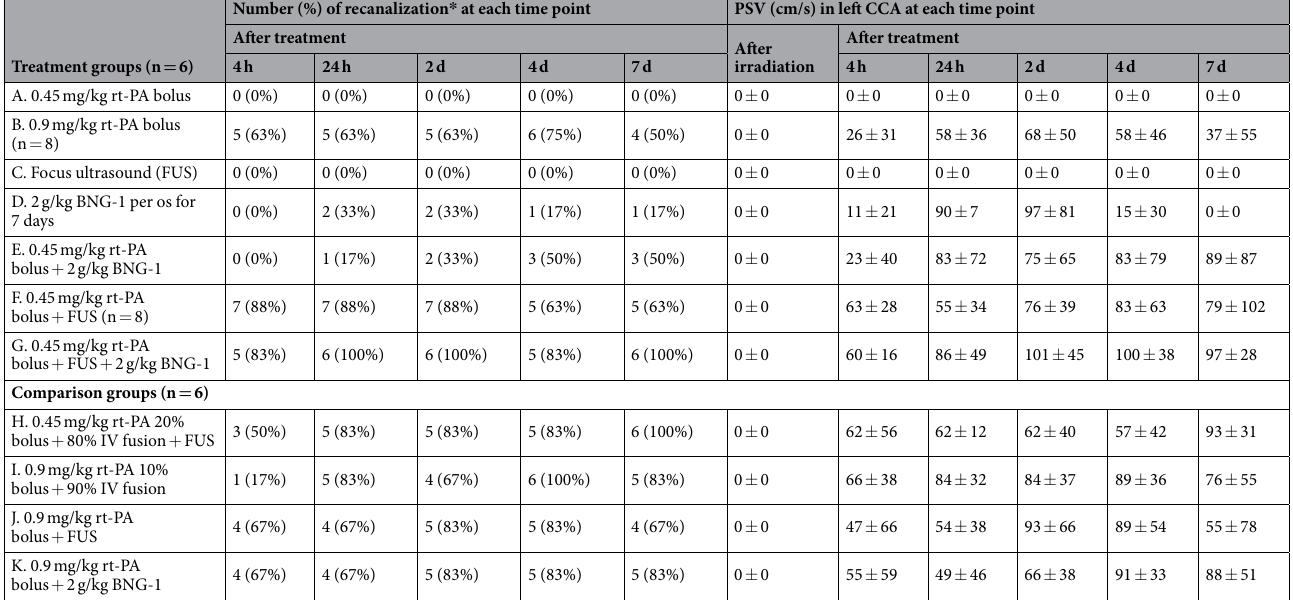
Table 1. Findings of small-animal ultrasound in the 7 treatment groups and 4 comparison